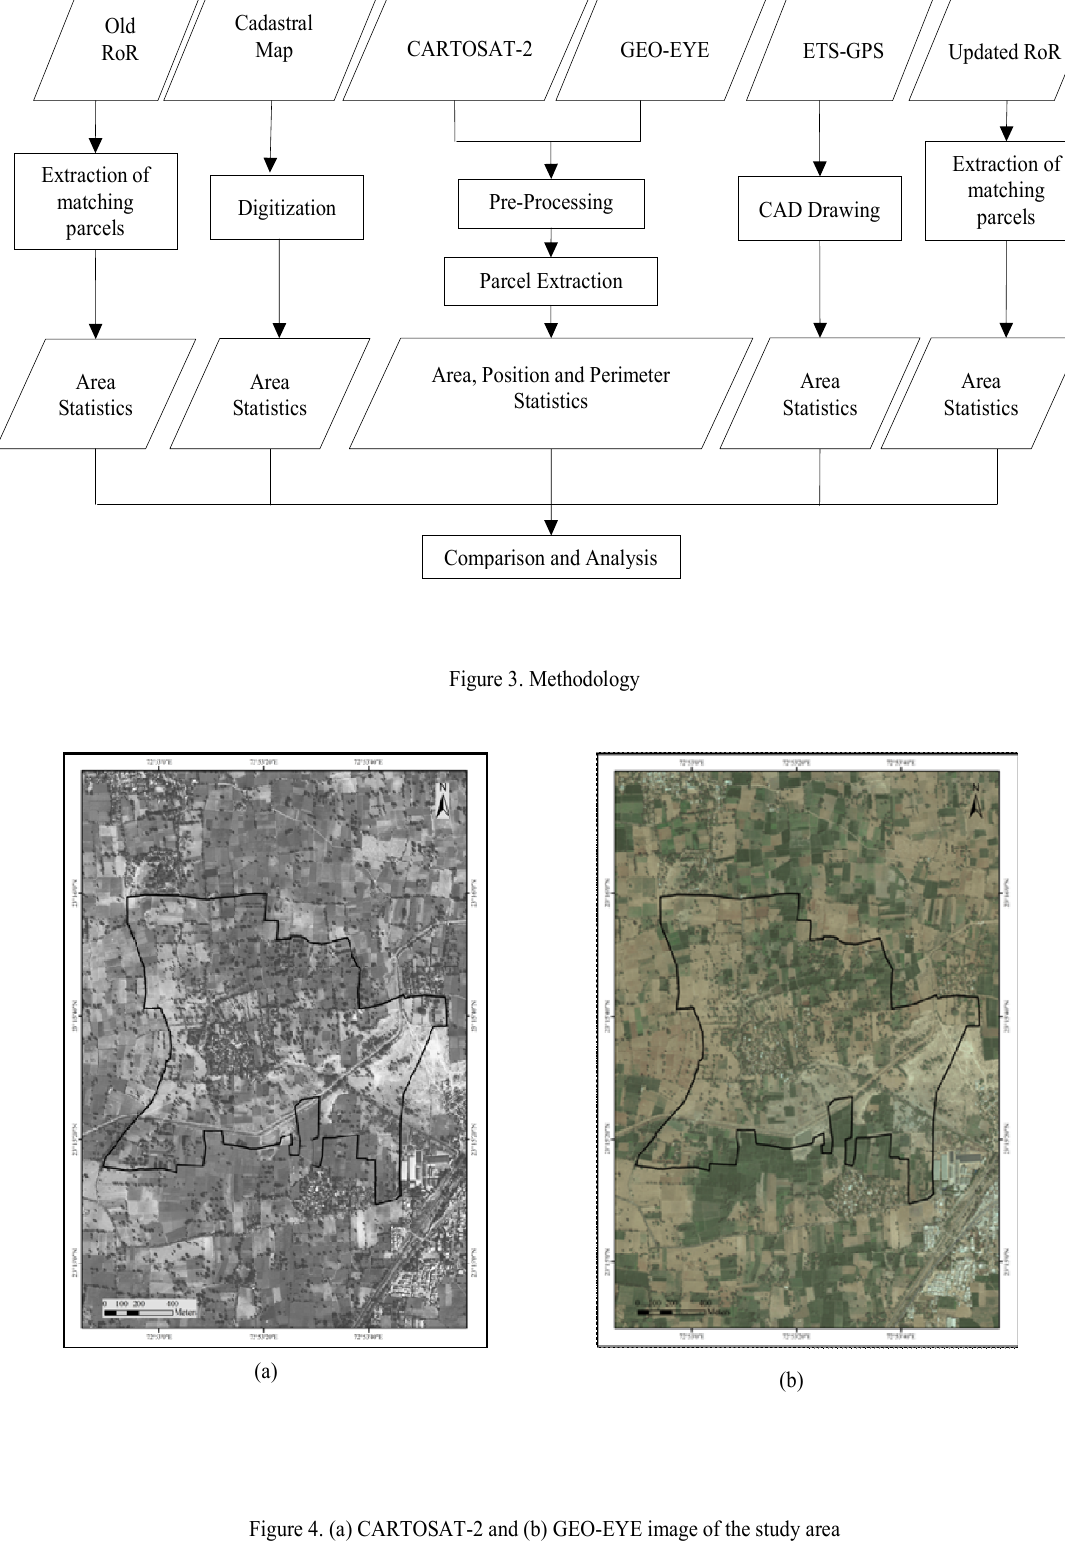
Figure 4. (a) CARTOSAT-2 and (b) GEO-EYE image of the study